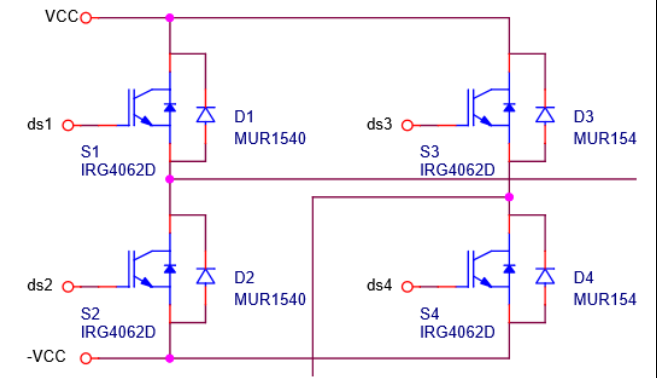
Figure 6: Power stage for an H-bridge. Source: [9].